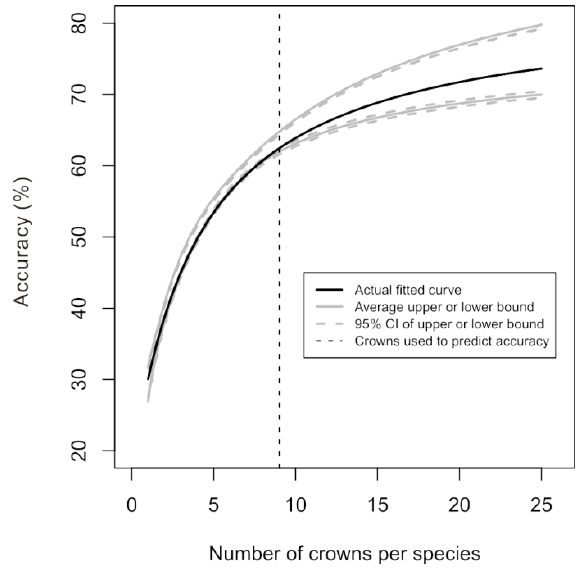
Figure 7. The accuracy relationship for the full 11 species model (solid black line), and the 95% confidence intervals (CIs) for estimates of the same relationship created by fitting the modified Michaelis-Menten function to the relationship produced from 1 to 9 training crowns. The mean (solid gray lines) and standard errors (dashed gray lines) of the lower and upper 95% confidence intervals estimated from the 100 replicates of this